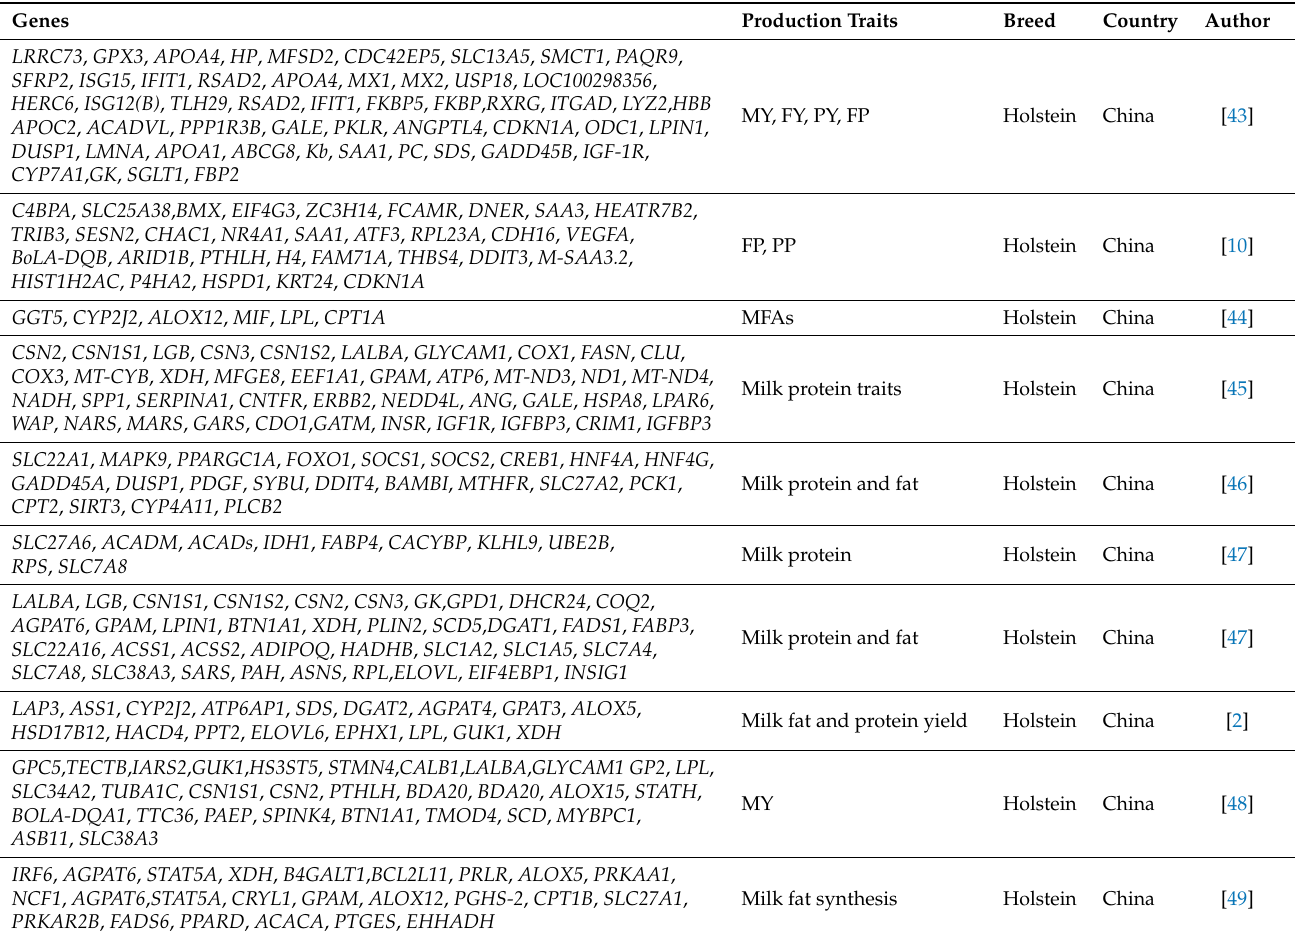
Table 2. Genes identified through the RNA-seq